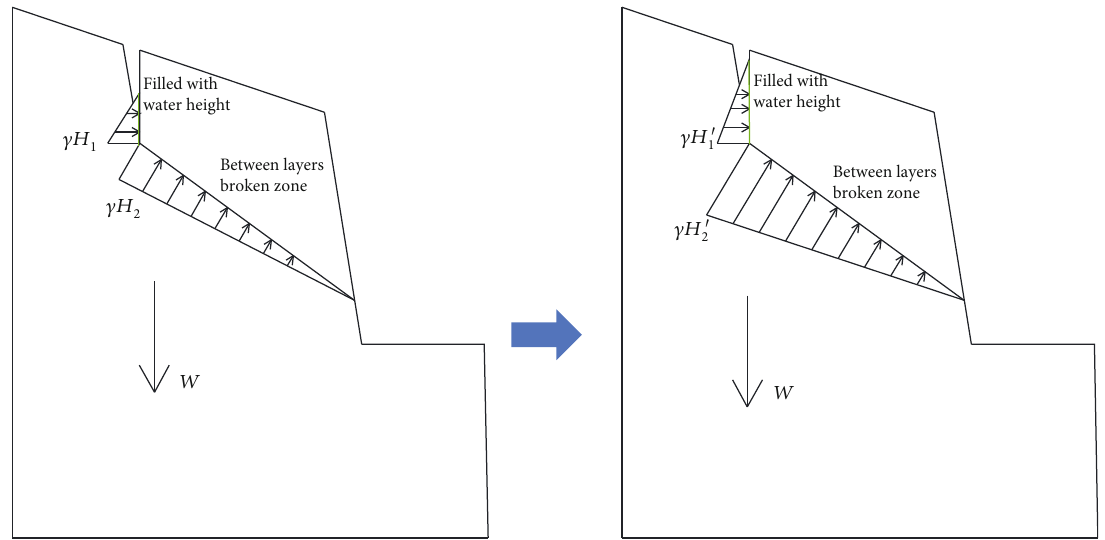
Figure 4: Schematic diagram of fracture water